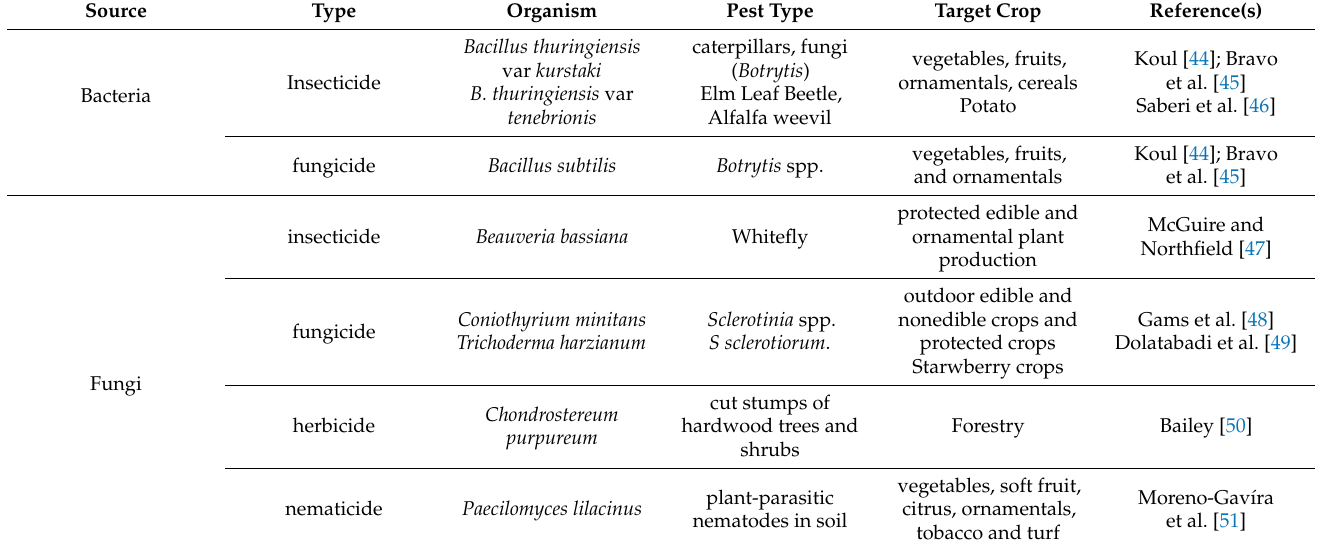
Table 1. A broad description of some common biopesticides, their types, sources, and target crops with the authors who published such